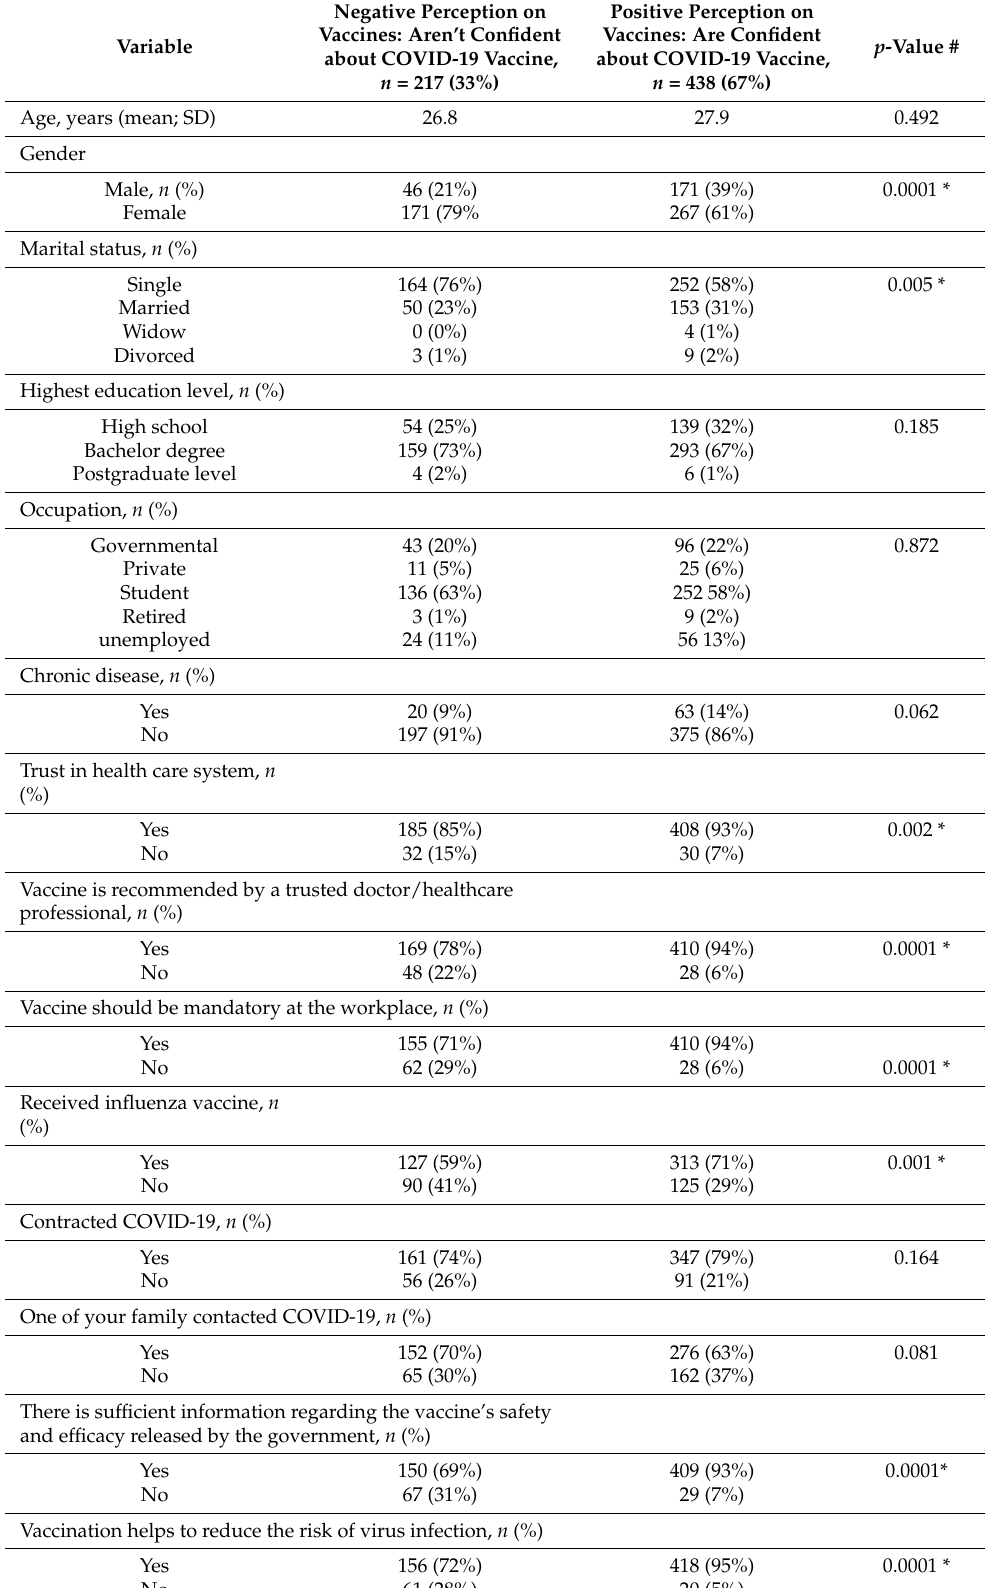
Table 3. Information about Participants Perception on COVID-19